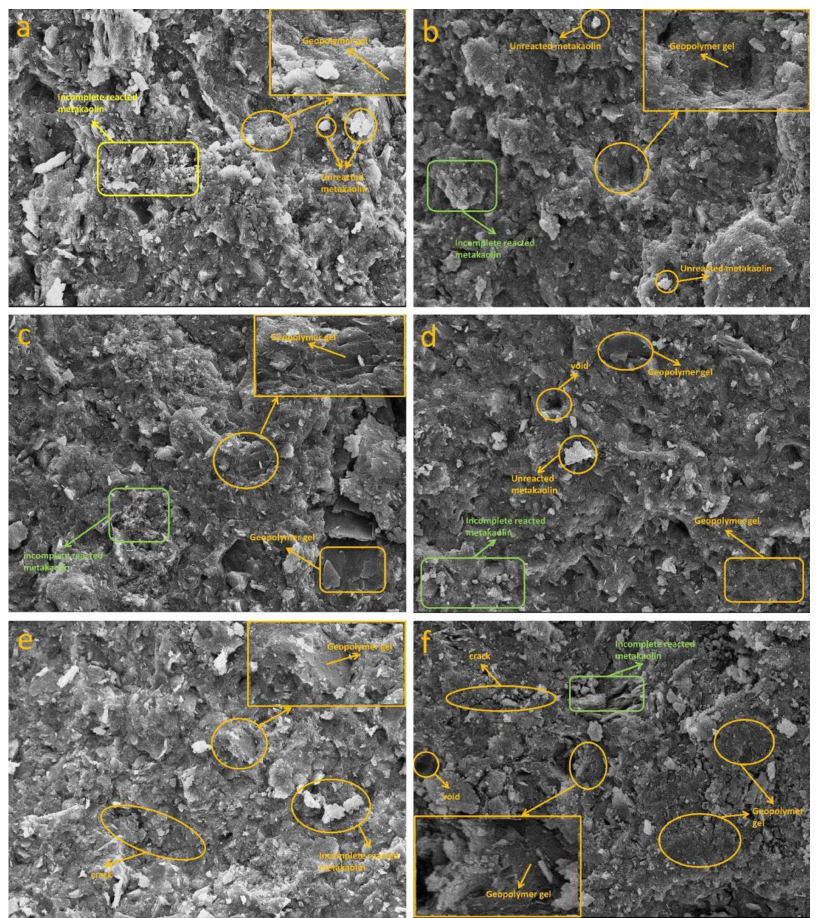
Figure 6. The 28-day SEM micromorphology of K-based geopolymers (K2, K3, K5, K7, K9, and K15 in ( a – f ),